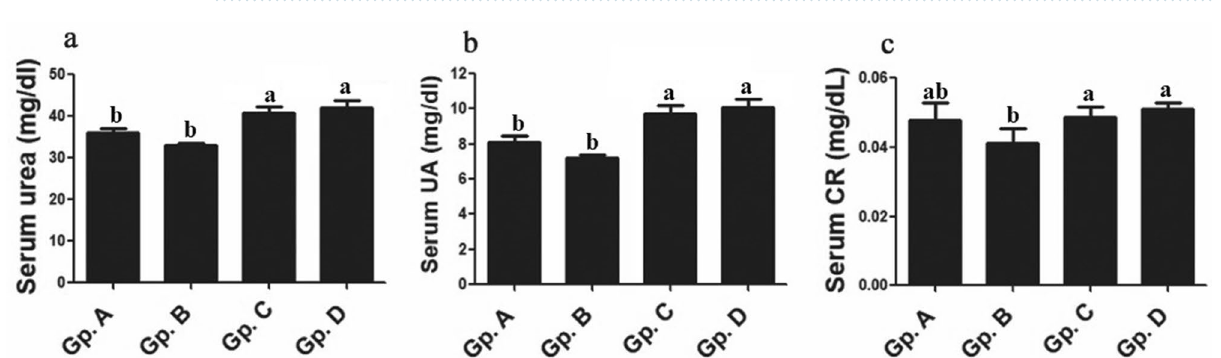
Figure 4. Effect of temperature changes on serum hepatic enzymes markers ( a : ALT; b : AST; c : ALP) in the different experimental groups of Dabb lizard ( U. aegyptia ). Gp. A: control group; Gp. B: low temperature exposed group; Gp. C: moderate temperature exposed group; Gp. D: high temperature exposed group; ALT: alanine aminotransferase; AST: aspartate aminotransferase; ALP: alkaline phosphatase. ab Means above each bar with different letters in different Dabb groups i.e. Gp. A, Gp. B, Gp. C and Gp. D, were significantly different ( P < 0.05).